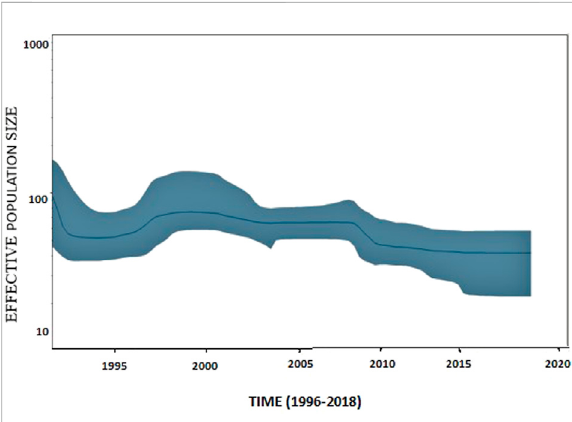
FIGURE 5 Bayesian skyline plot of VHSV based on G -gene features. Bayesianskylineplot(BSP)illustratesthevariationinVHSVeffective population size over time. The effective population size (Ne) is representedonthey-axis,andgenerationtimeisrepresented on the x-axis in years. A blue line represents the mean effective population size. The 95% HPD (highest posterior density) of genetic diversity estimations is depicted by the shaded blue